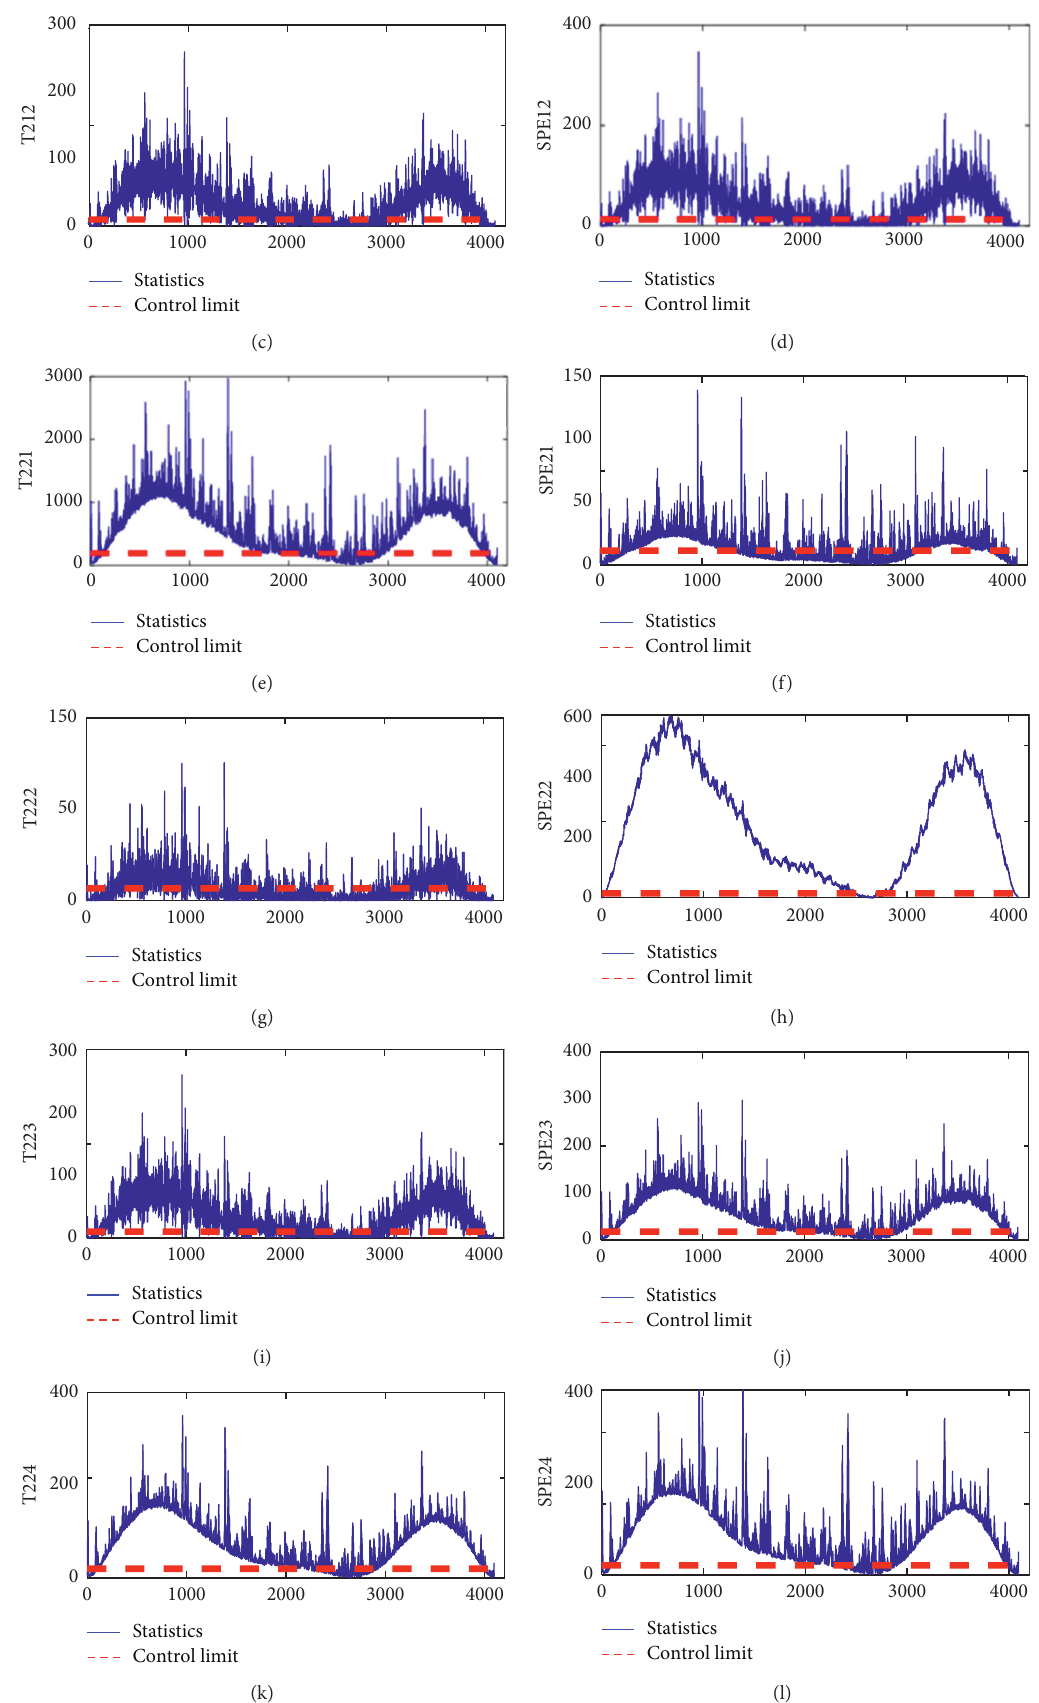
Figure 16: Mechanical failure comprehensive simulation experiment bearing inner ring failure results based on Deep